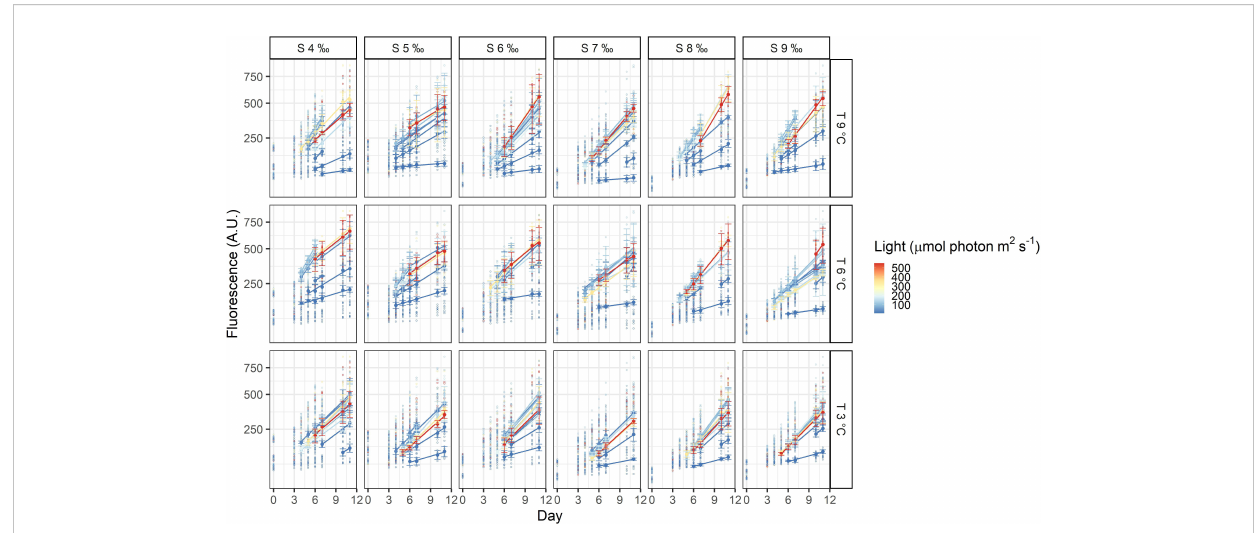
FIGURE 3 Fluorescence time series of Apocalathium malmogiense . Each circle is the observed fl uorescence of each well in each day. Daily means and standard deviations of the observations used to calculate the growth rates are depicted as full points with the error bars. The lines are linear regressions, included only for visualization purposes.